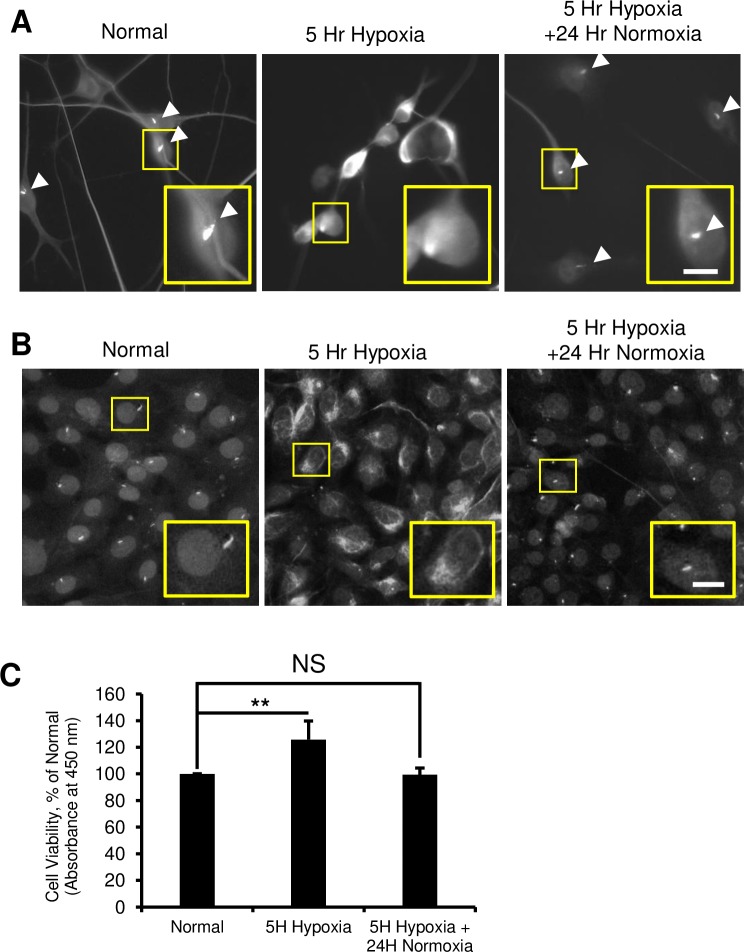
Hypoxia causes reversible neuronal cilia resorption.(A and B) Normal N1E-115 cells (Left A) and HT22 cultures (Left B) exhibited primary cilia (arrowheads in A) demonstrated by immunofluorescence against Actub. Five hours of hypoxia (middle) resulted in the loss of primary cilia and diffuse staining of Actub in both cell lines (Middle panel). Following hypoxia, 24 hours of normoxia returned the expression of primary cilia in both cell lines (Right). N1E-115 Scale bar = 25 μm, HT22 Scale bar = 10 μm. (C) Quantification of N1E-115 cell survival by WST-8 assay showing increased metabolic activity at 5 hours of hypoxia that normalized after 24 hours of normoxia. Data presented as mean ± SEM relative to normal. ** p<0.01.